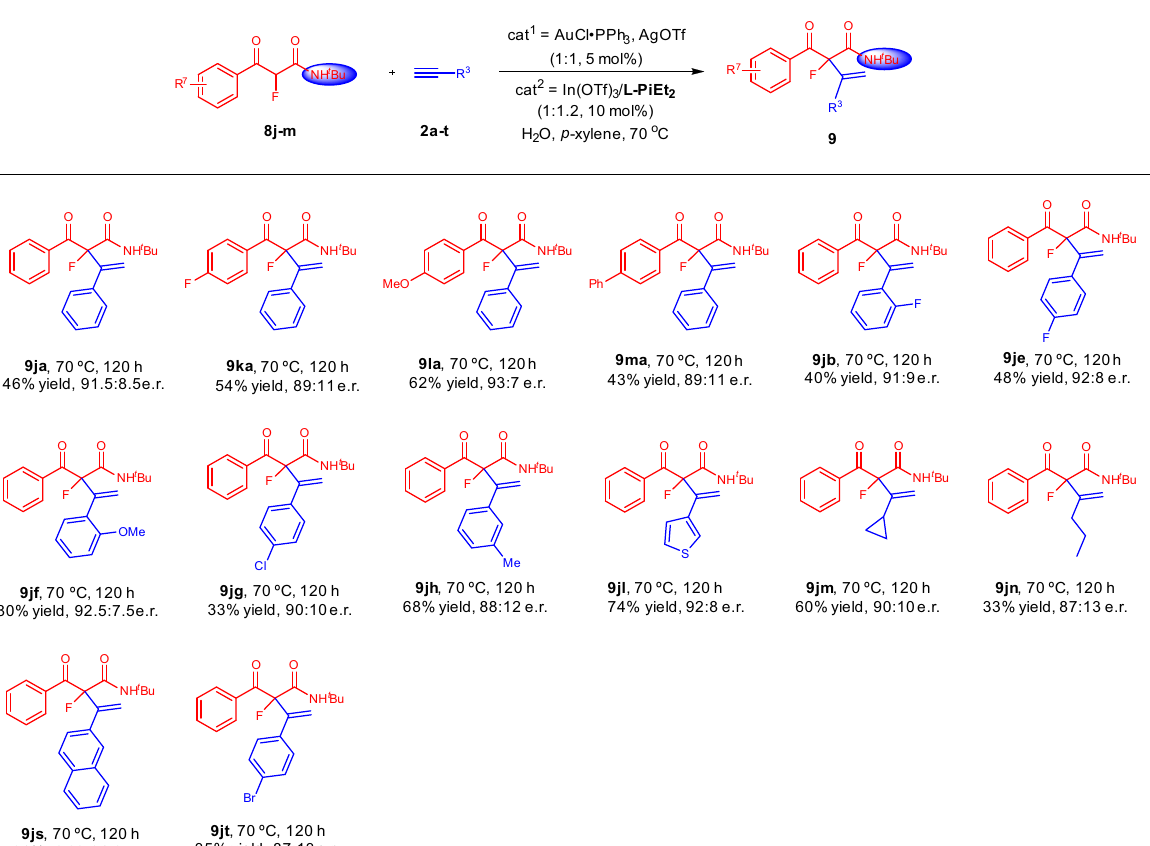
Fig. 5 Substrate scope of α - fl uoro substituted acyclic β -ketoamides. Unless otherwise noted, all reactions were carried out, AuCl ∙ PPh 3 /AgOTf (1:1, 5 mol %), In(OTf) 3 / L-PiEt 2 (1:1.2, 10 mol%), 8 (0.10 mmol) and 2 (3.0 equiv), H 2 O (2 μ L) as additive in p -xylene (1.5 mL) at 70 °C for 120 h.